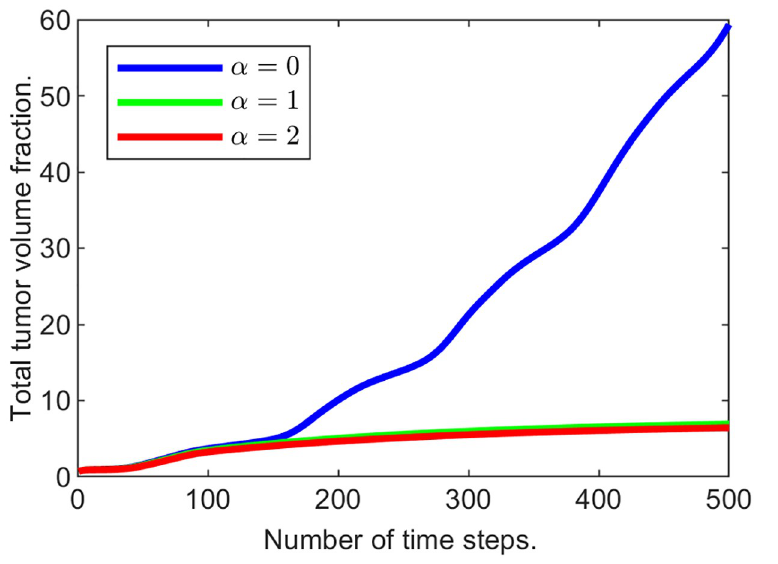
Fig 16. Tumor mass changing with time for various optimal ECM volume fraction values.